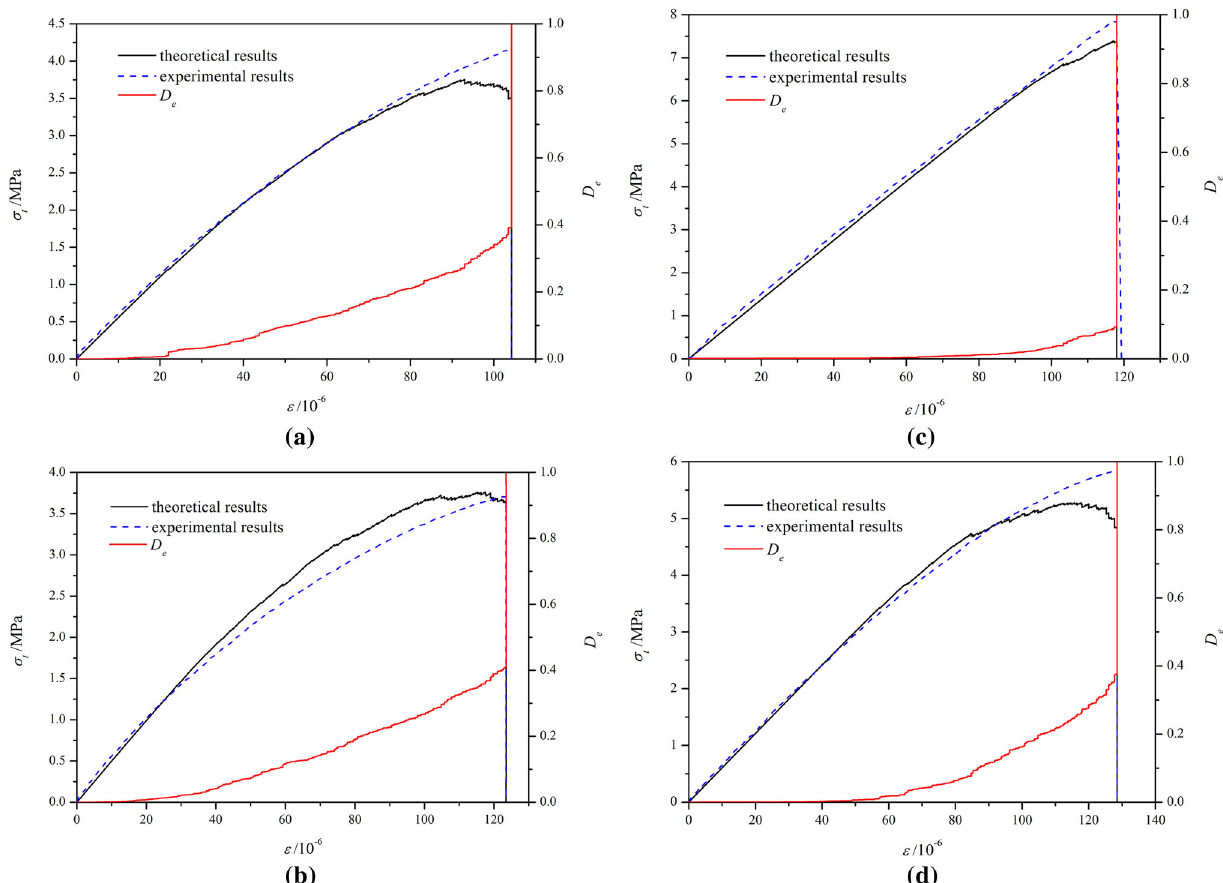
Fig. 9 Comparison of the theoretical simulated results based on AE energy factor and the test results. a Specimen A1, b specimen A2, c specimen B2, d specimen